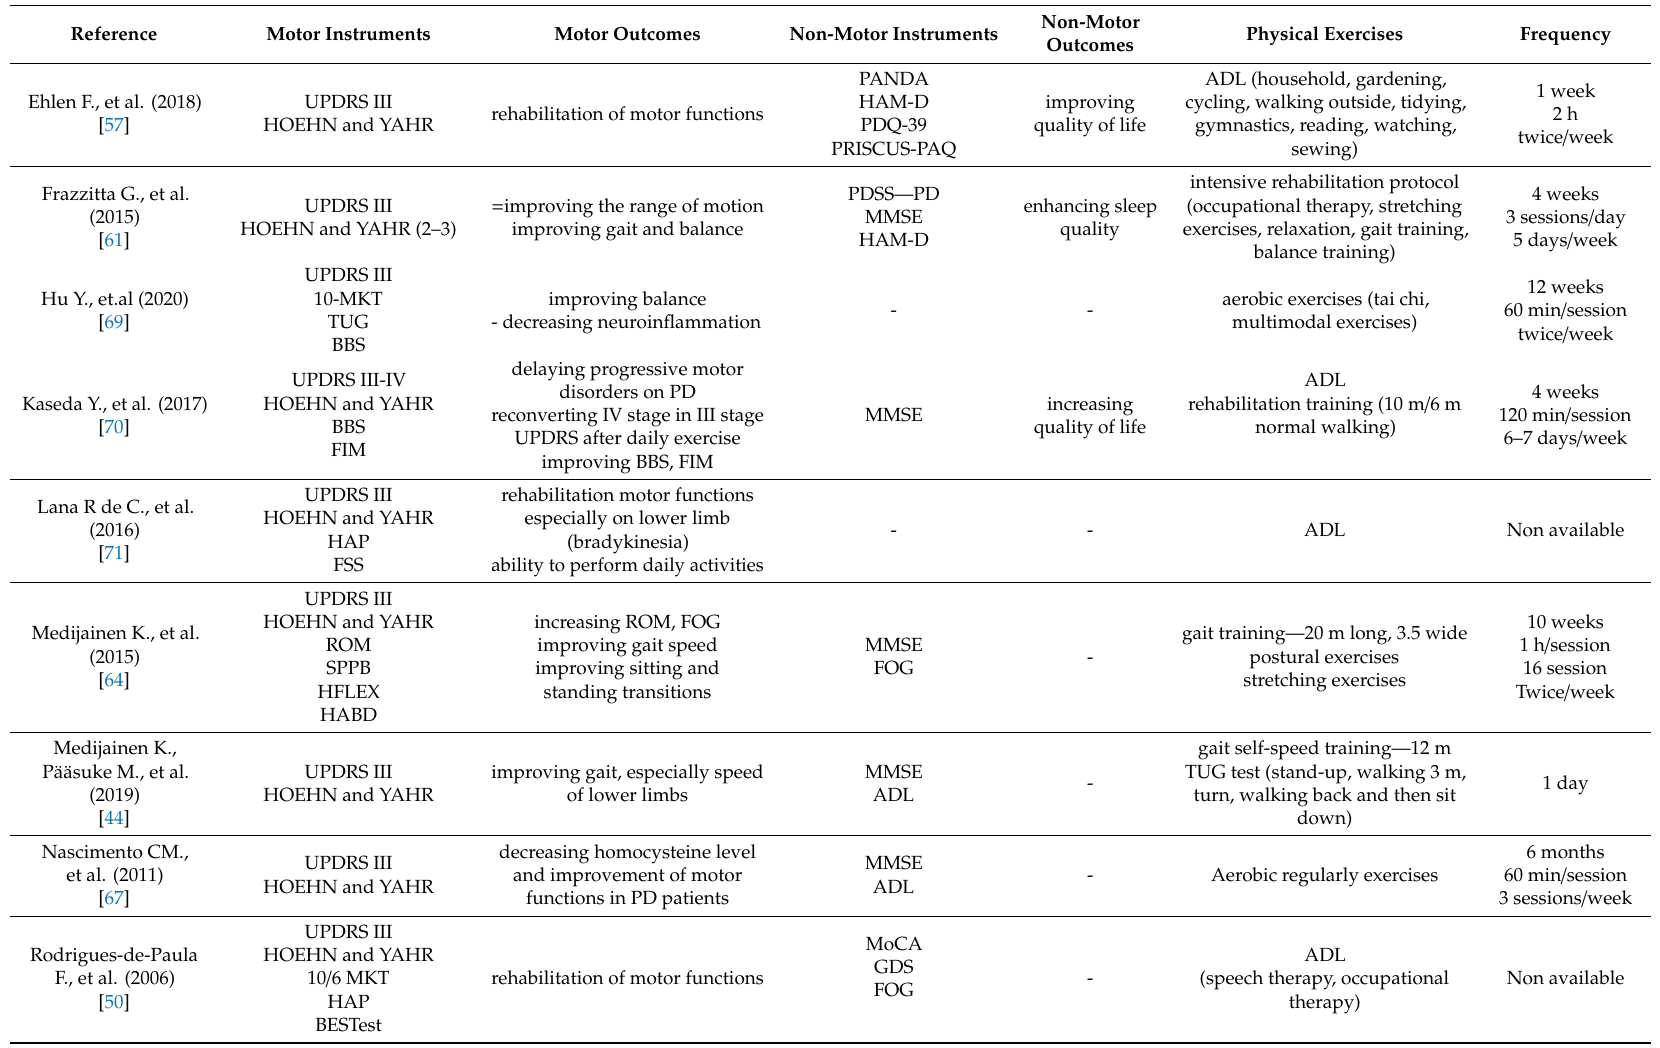
Table 1. Summary of the main physical